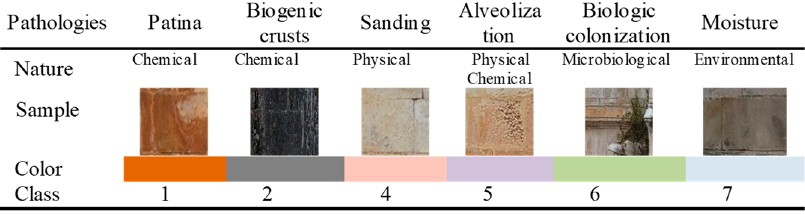
Figure 4. Six main types of manually identified pathologies: patina, biogenic crusts, alveolization, sanding, biologic colonization and moisture.